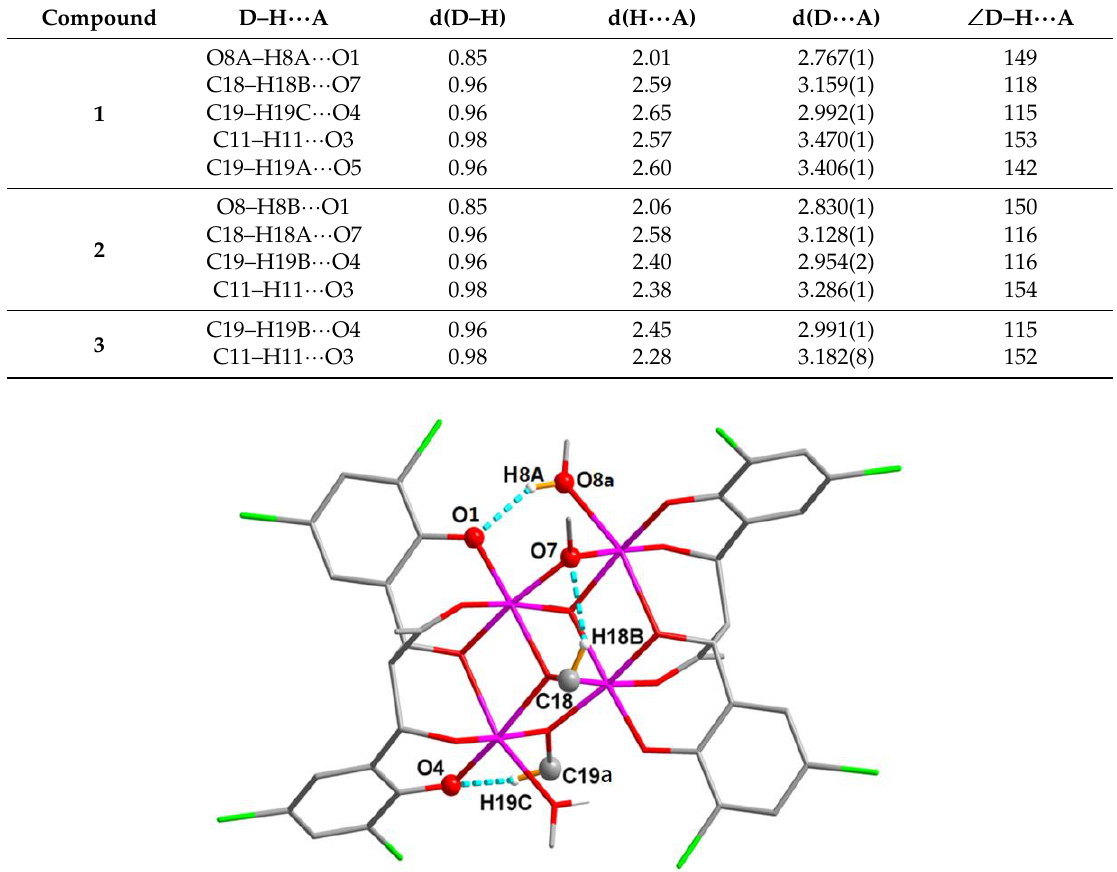
Figure 5. Part of intramolecular C–H···O hydrogen-bonding interactions in Mn III complex 1 (symmetry code: a = 1 − x, 1 − y, 1 − z).